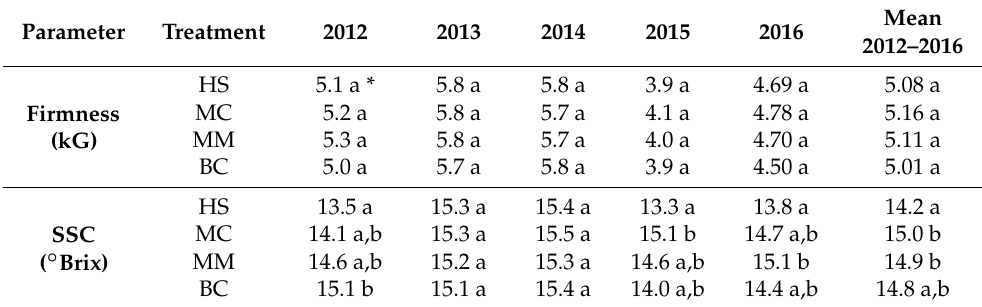
Table 3. Fruit quality parameters of apple tree cv. Gold Chief grown in different soil management systems measured after ten weeks of storage during